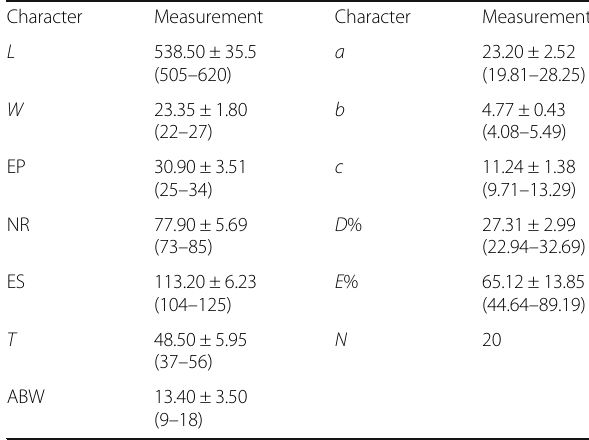
Table 1 Morphometric of infective juveniles of Steinernema carpocapsae IRMoghan. All measurements are in micrometers